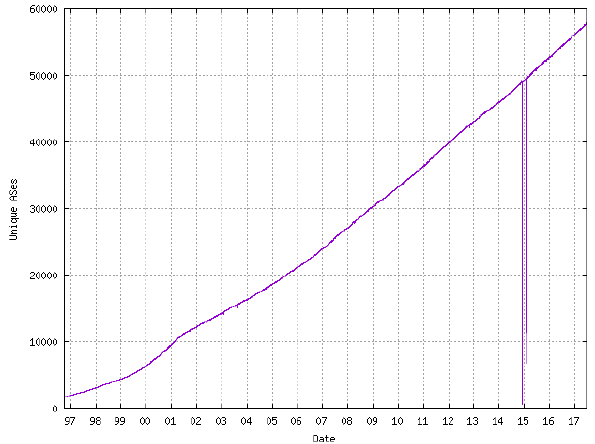
Figure 12. Global AS count in November 2017 [36].